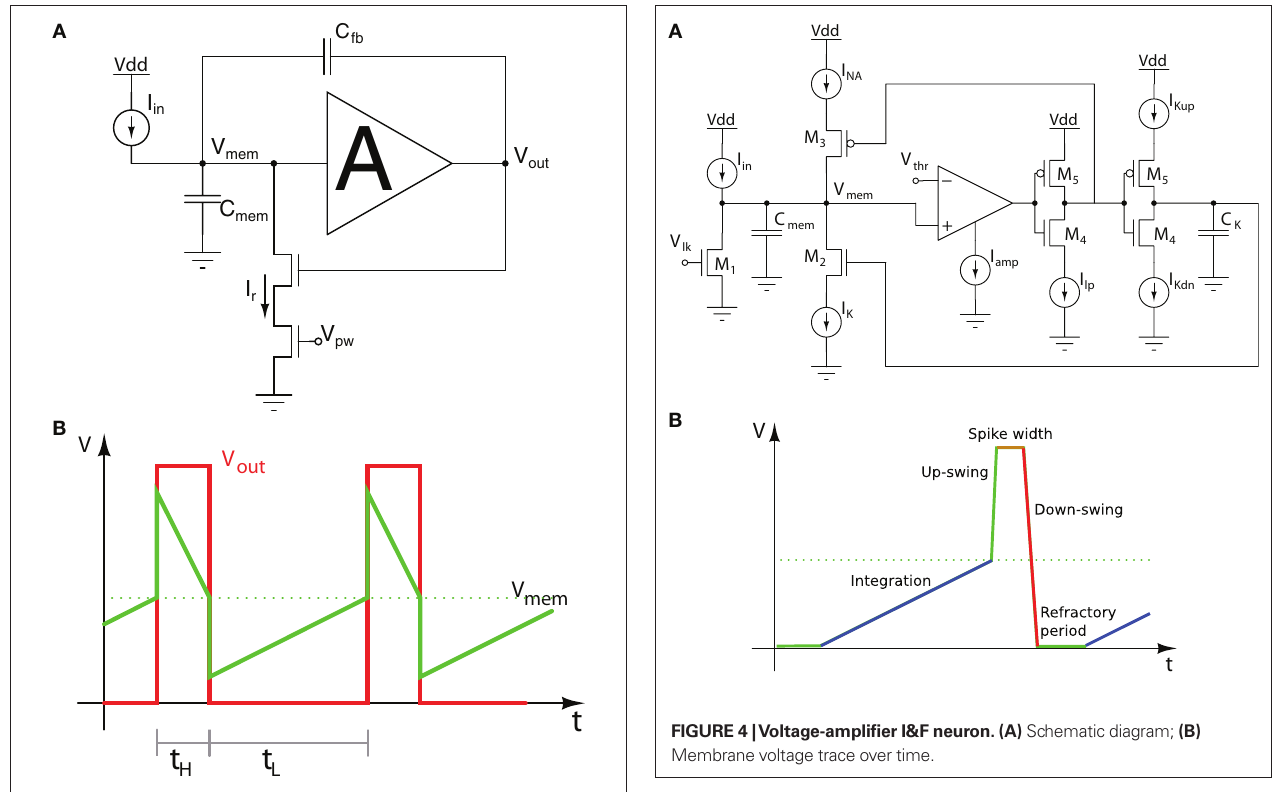
FIgure 3 | axon-hillock circuit. (a) Schematic diagram; (b) Membrane voltage and output voltage traces over time.